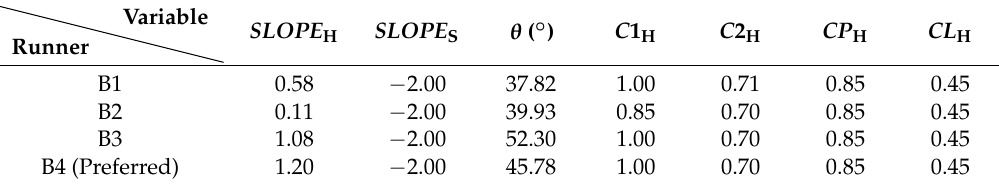
Table 6. Optimized parameters by the second step